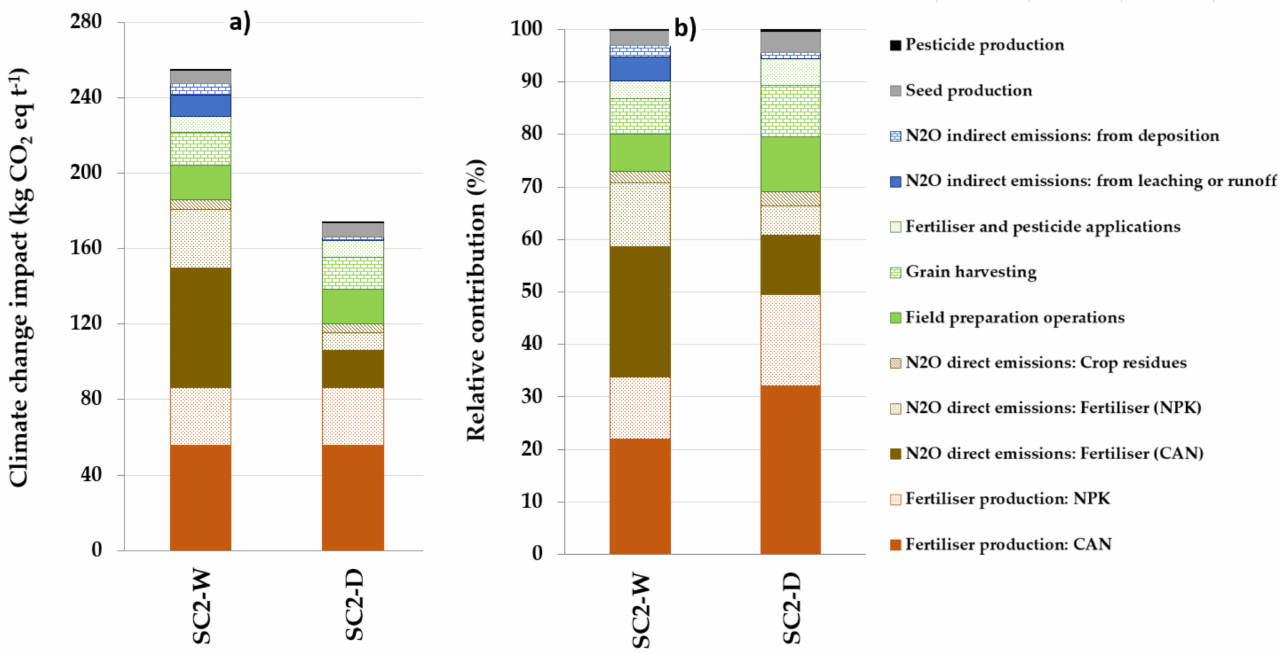
Figure 5. Results of the sensitivity analysis in terms of ( a ) climate change impact (kg CO 2 eq t − 1 ) and ( b ) percentage of deviation from the baseline scenario. BS1: Baseline scenario; SC1: IPCC 2006 + economic allocation; SC2: IPCC 2019 + mass allocation; SC3: IPCC 2019 + economic allocation.